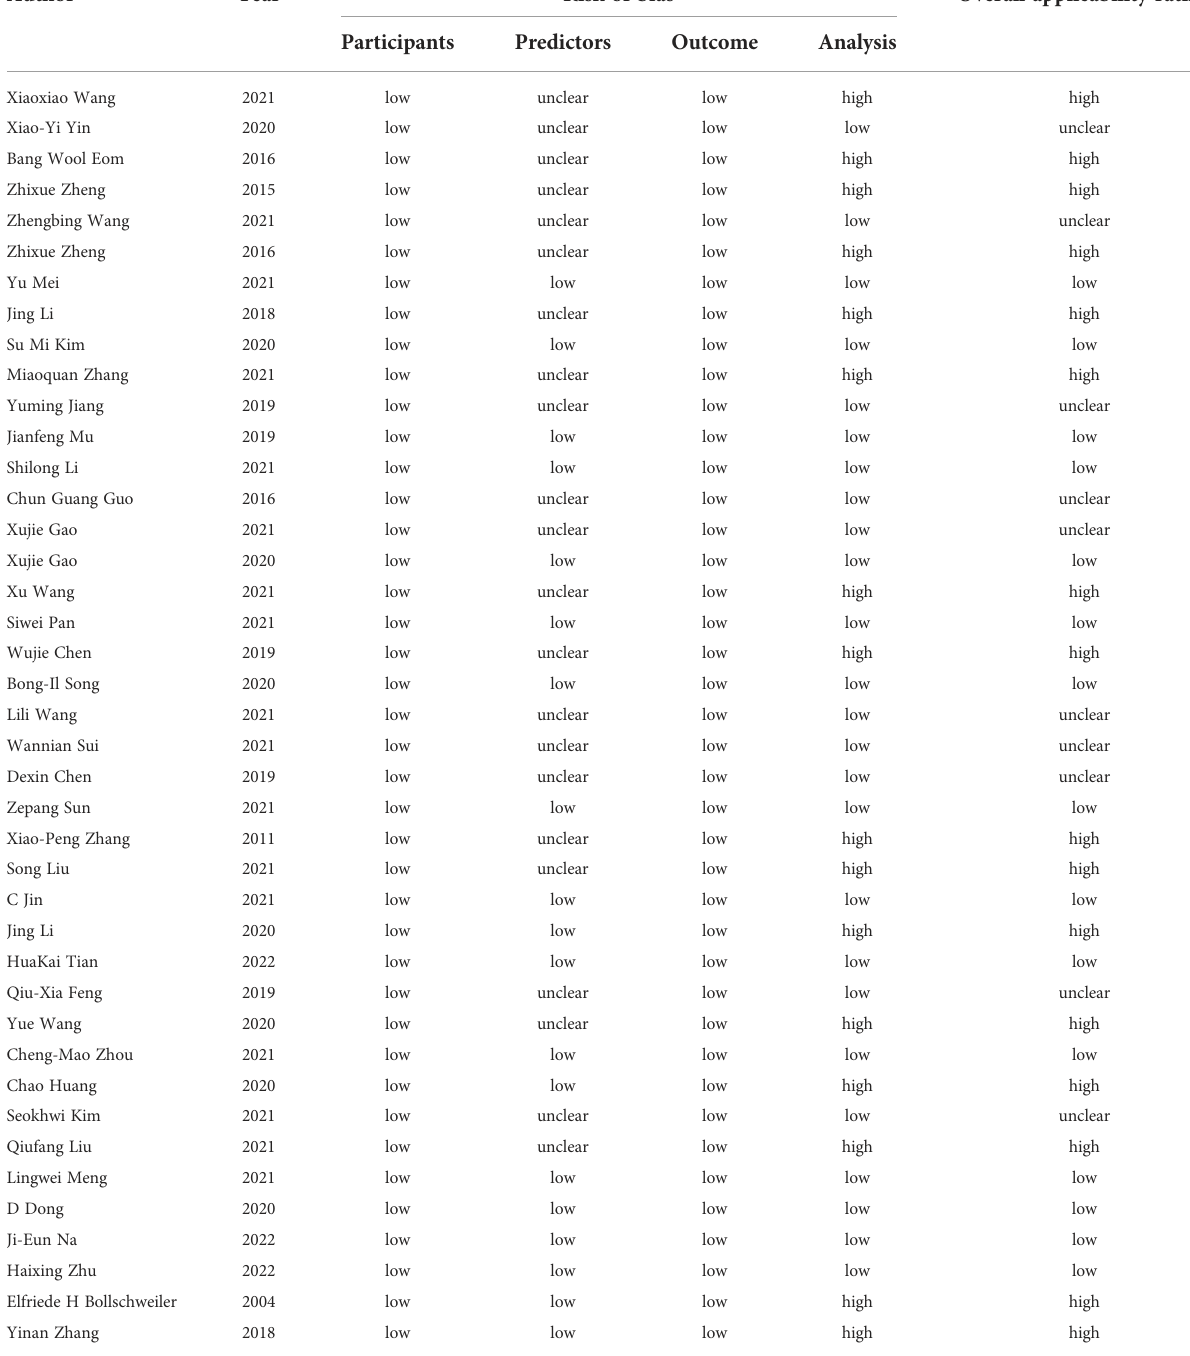
TABLE 2 Risk of bias and applicability assessment by PROBAST